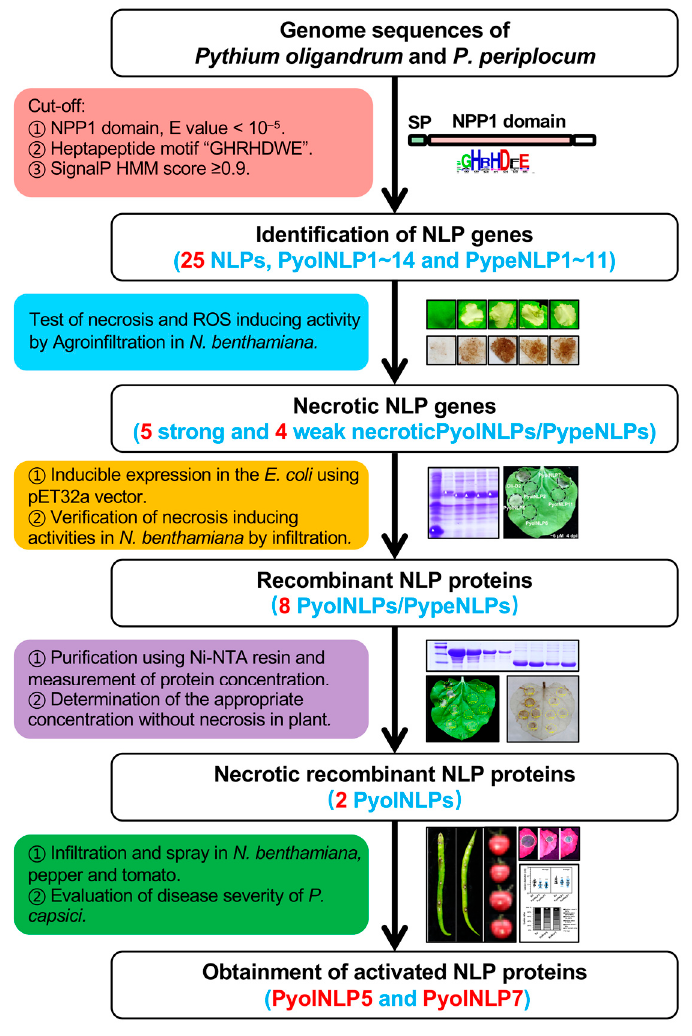
Figure 1. Strategy for identifying bioactive Nep1-like proteins (NLPs) from Pythium oligandrum and Pythium periplocum . Candidate NLP genes were identified from P. oligandrum and P. periplocum genomes using a bioinformatics pipeline. They were then agroinfiltrated in N. benthamiana leaves to screen necrosis-inducing NLPs . Necrotic NLPs screened out were expressed in E. coli and purified for functional assays, including direct infiltrations in N. benthamiana for the determination of their threshold concentrations for necrosis induction and disease suppression evaluation. Finally, the bioactive NLP proteins selected were used to infiltrate and spray solanaceous plants. Disease severity was evaluated after P. capsici inoculation.